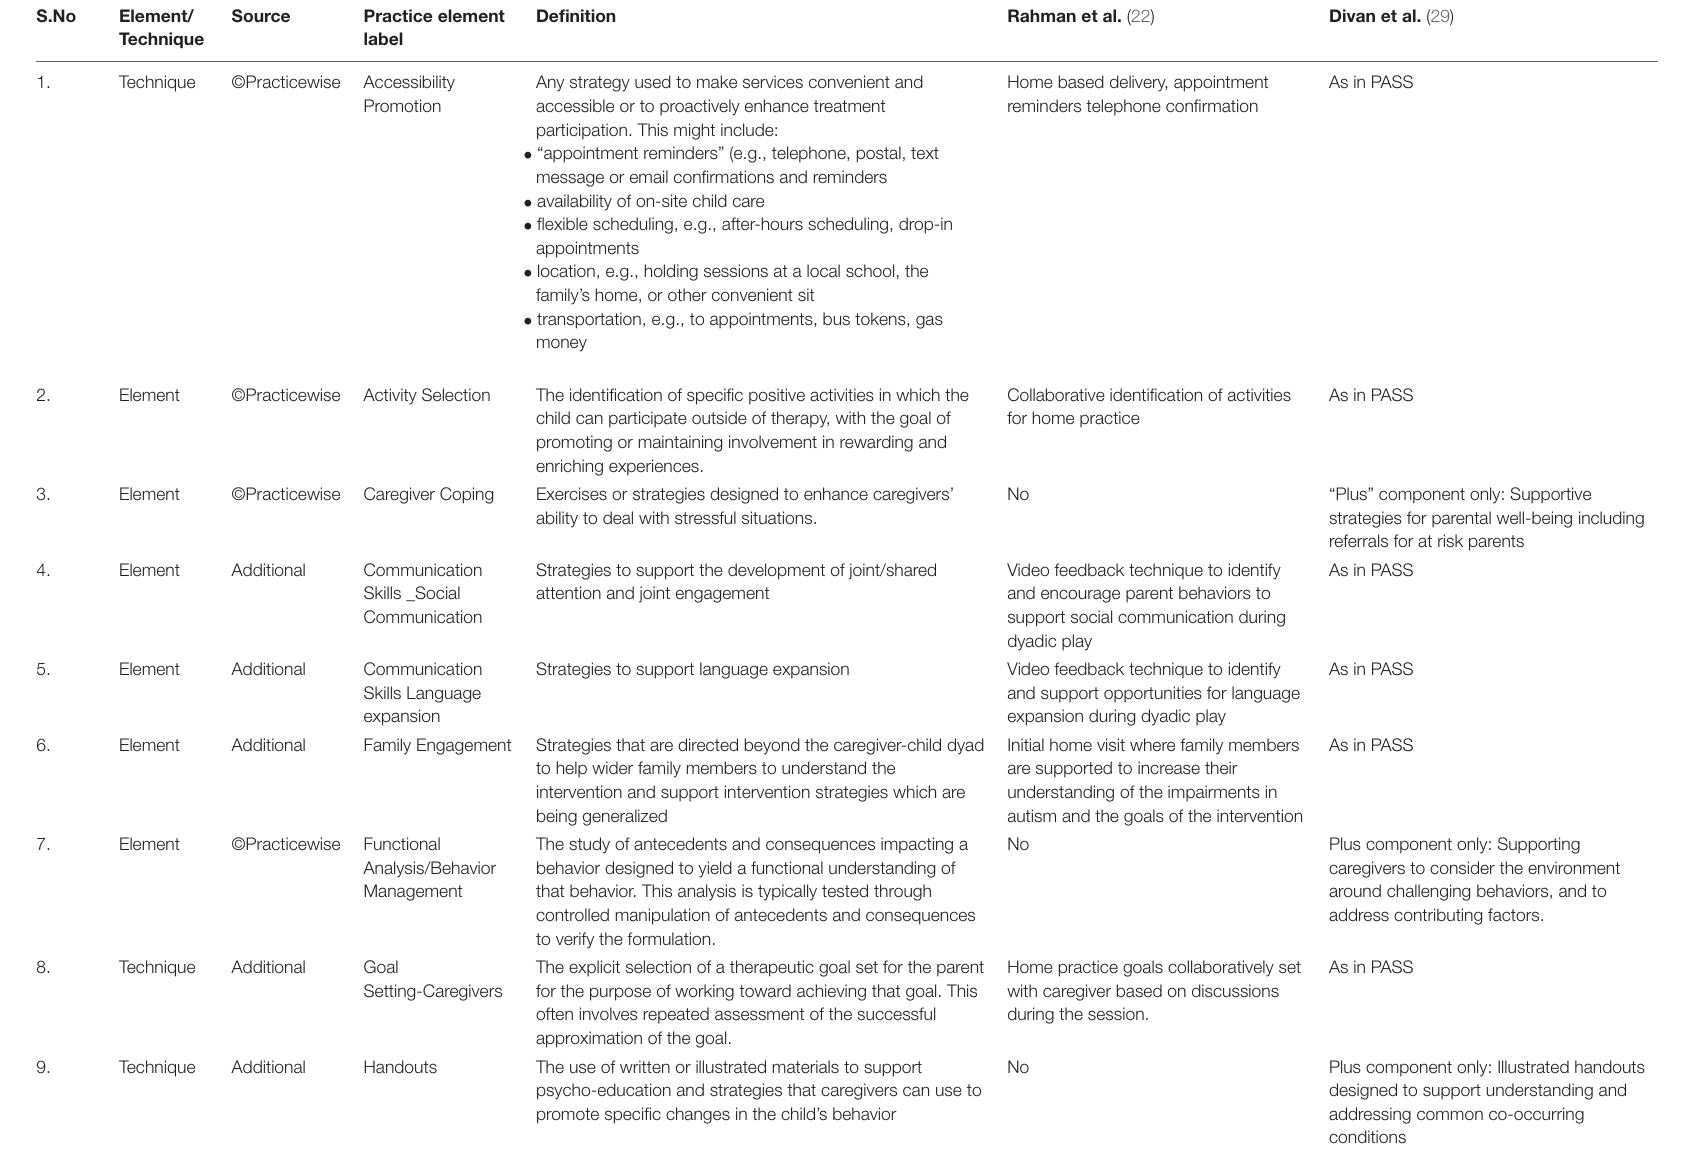
TABLE 4 | List of common components based on the @PracticeWise framework